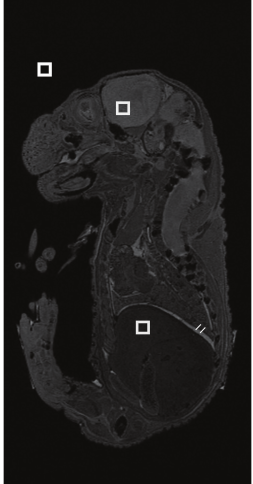
Figure 4: 2D slice image of the ex vivo embryo illustrating the location of 9×9×9 voxel ROI chosen for SNR and CNR calculations and sample edge profiles chosen to calculate the edge